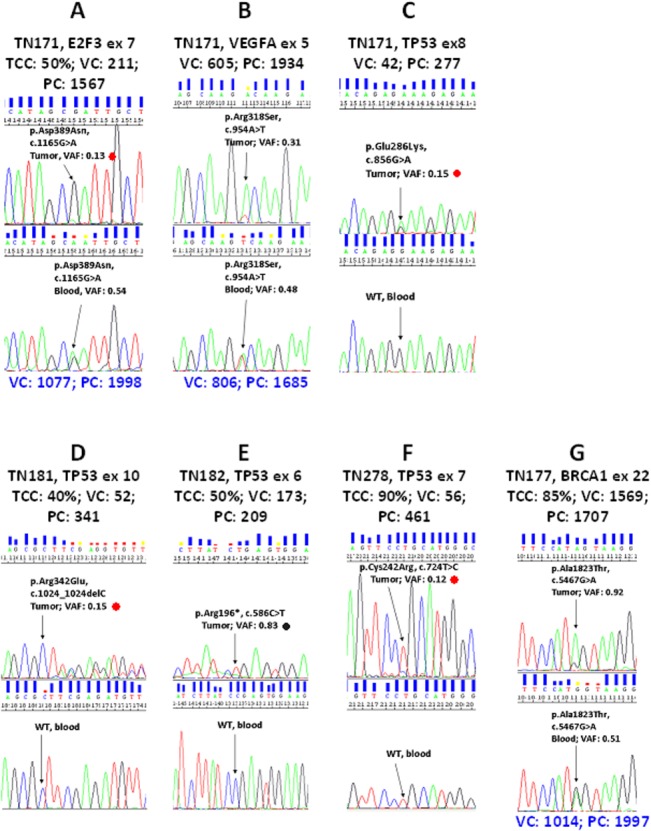
Sanger sequencing validation of MPS variants.Five cases with matched tumor—blood samples are shown. Annotations in black letters are given for tumors (FFPE); in blue letters for germline (blood). TCC: approximate tumor cell content in the DNA sample; VC and PC: variant and position coverage with MPS; VAF: Variant frequency (VC/PC). The same DNA samples were used per case for both methods. A—C: same case, DNA quality unfavourable, three variants in tumor, two in germline. D—F: individual cases with unfavourable (D and E) and favourable (F and G) DNA quality. Sanger sequencing peaks usually but not always corresponded to MPS VAF. In A, D and F, perhaps in B as well, variants would have been missed with Sanger sequencing only. Note target specific differences in position coverage, which derives from amplicon reads. Red dots: low VAF. Black dot: the expected wild type allele at 17% frequency, based on MPS VAF, was not observed with Sanger sequencing.